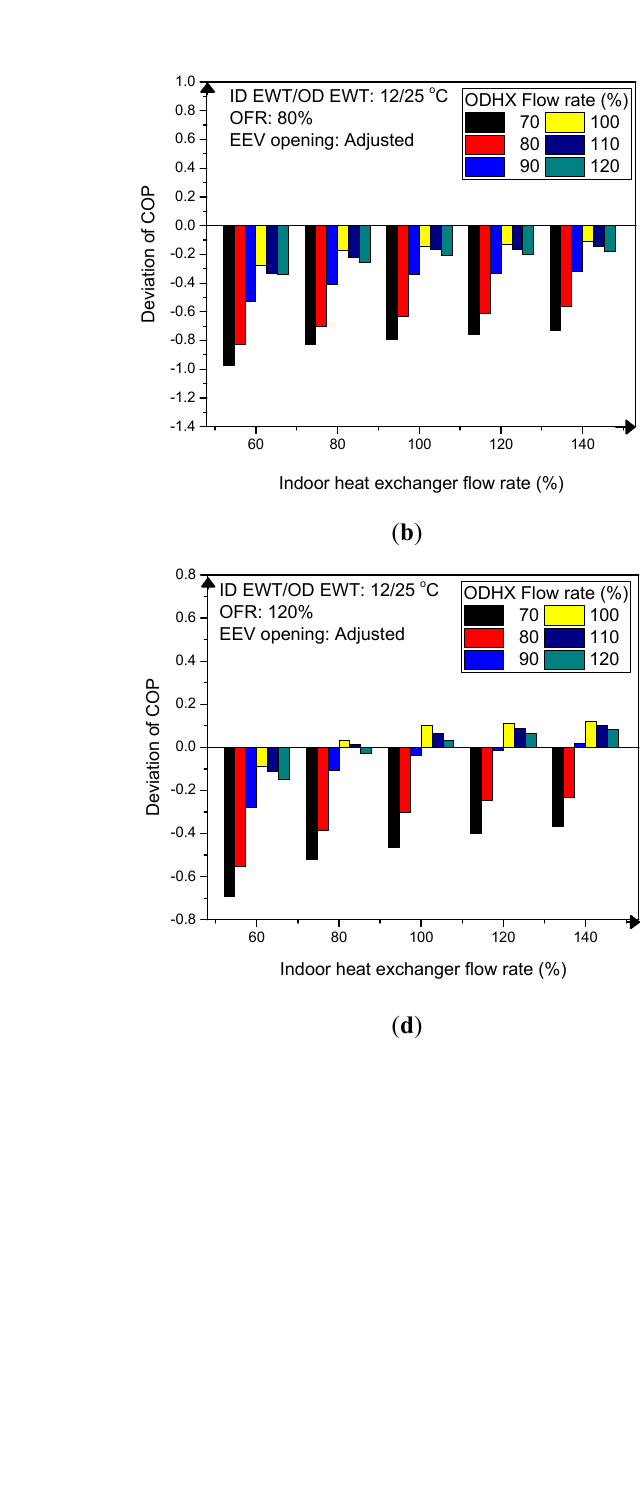
Figure 8. Change in cooling capacity according to refrigerant charge and flow rate of secondary fluid in indoor and out- 275 door heat exchanger of ( a ) 60%, ( b ) 80%, ( c ) 100%, ( d )120% and ( e ) 140%.